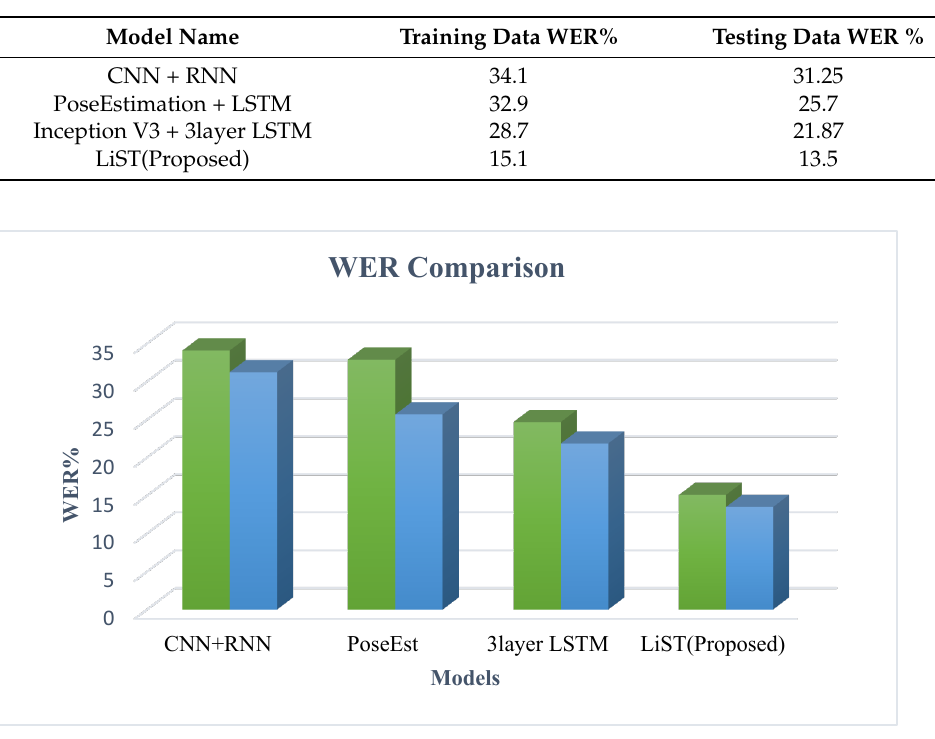
Figure 10. Training and testing WER comparison. Table 5. WER comparison of different sign language translators using the INCLUDE dataset.